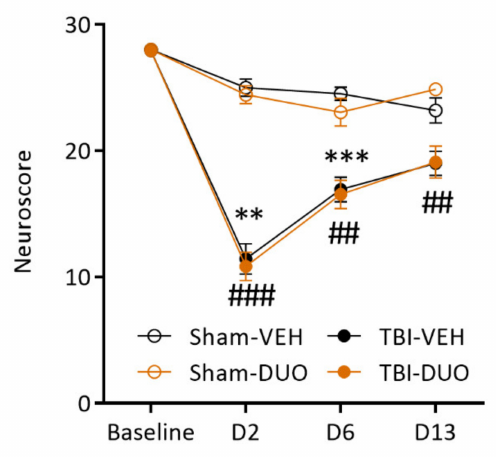
Figure 5. Composite neuroscore in rats treated with vehicle or SFN+NAC duotherapy. The TBI- VEH group showed impairment on day (D) 2 and D6 post-injury and the TBI-DUO group showed impairment on all testing days till D13 post-TBI. No difference was detected between Sham-VEH and Sham-DUO or TBI-VEH and TBI-DUO groups at any time-point ( p > 0.05). Abbreviations: D, day; DUO, duotherapy treated with N-acetylcysteine and sulforaphane; NAC, N-acetylcysteine; SFN, sulforaphane; TBI, traumatic brain injury; VEH, vehicle. Statistical significances: ** p < 0.01, *** p < 0.001 (Sham-VEH vs. TBI-VEH, Mann–Whitney U -test); ## p < 0.01, ### p < 0.001 (Sham-DUO vs. TBI-DUO, Mann–Whitney U -test). Data are presented mean ± SEM. Beam